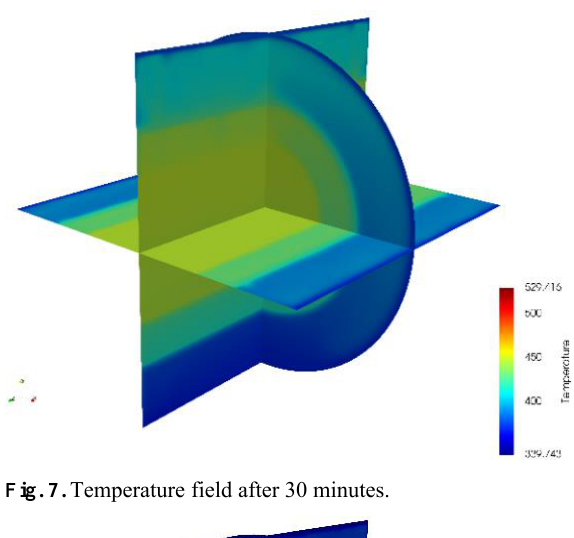
Fig. 6. Temperature field after 15 minutes .